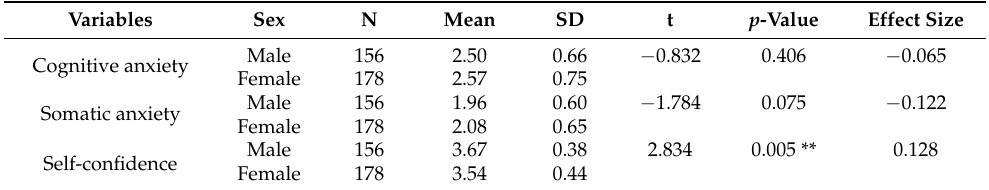
Table 3. Differences between female and male athletes.